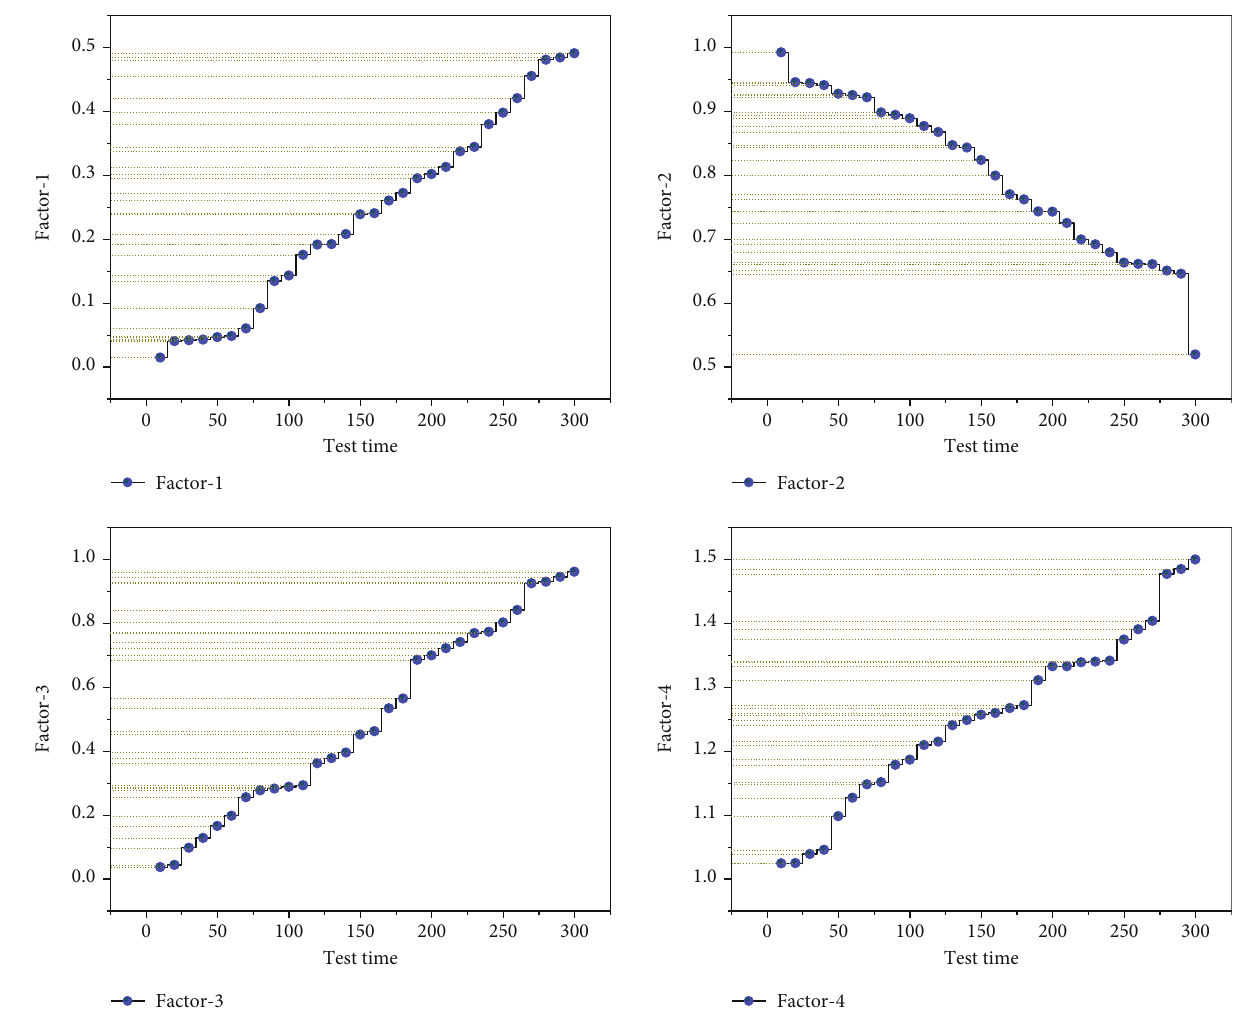
Figure 4: Considerations of college students ’ participation in labor practice activities.